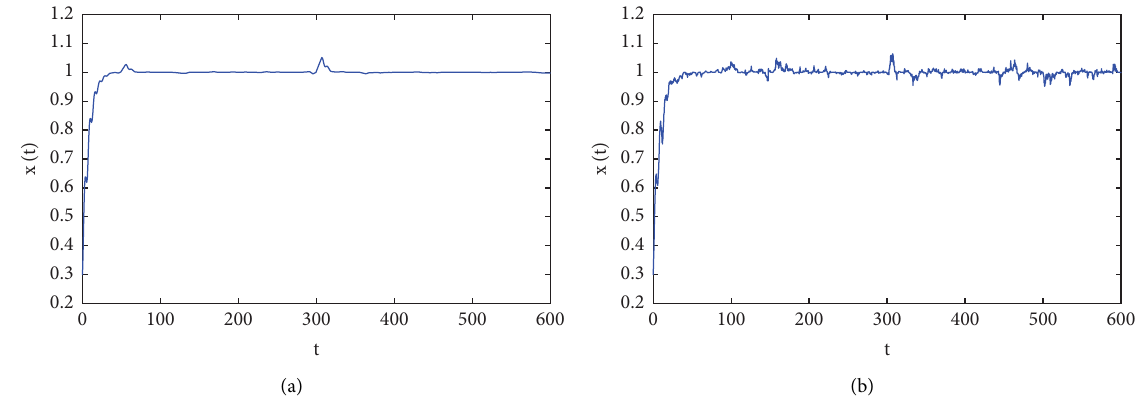
Figure 5: Te lines represent the solution of model (8) for r ( t ) � 0 . 4 + 0 . 5sin t, K � 1 ,C � 1 . 2, initial data x (a) a ( t ) � 0 . 1 , σ ( t ) � 0 , c ( u ) � 0; (b) a ( t ) � 0 . 1 , σ ( t ) � 0 . 2 , c ( u ) � 0